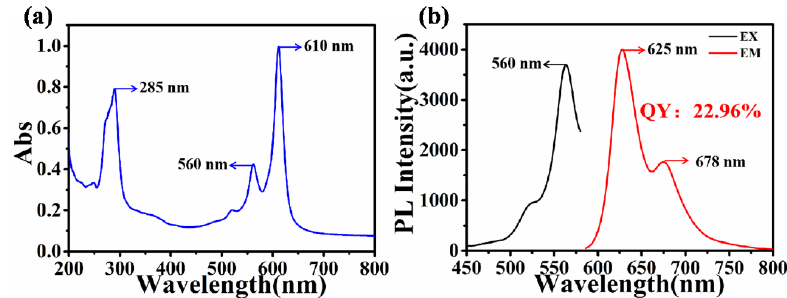
Figure 1. The UV-Visible absorption ( a ), excitation and emission spectrum ( b ) of R-CDs.